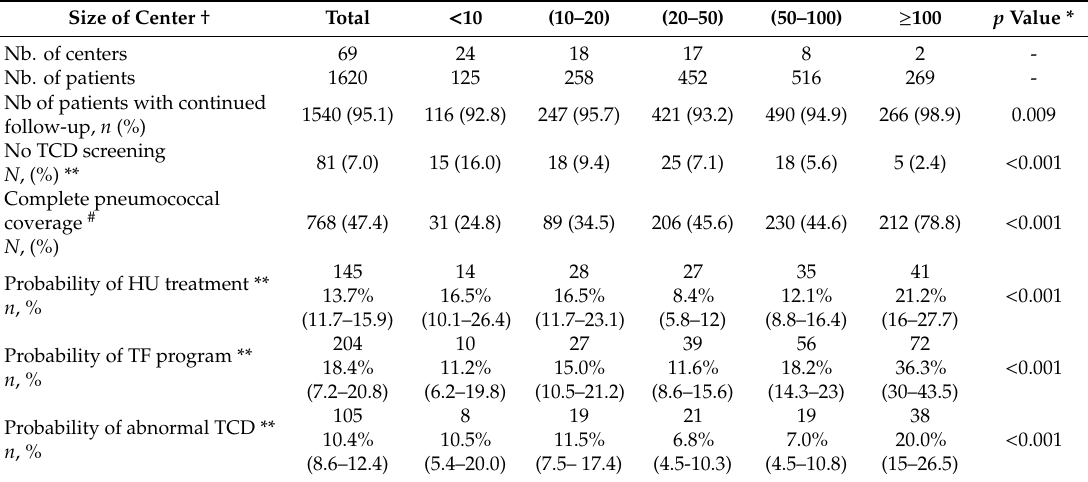
Table 2. Outcomes and coverage rates by five years of age according to center